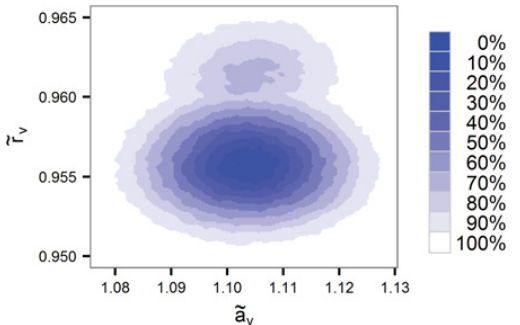
Figure 1. Approximation of the posterior distribution. The different shades of blue indicate the confidence areas.